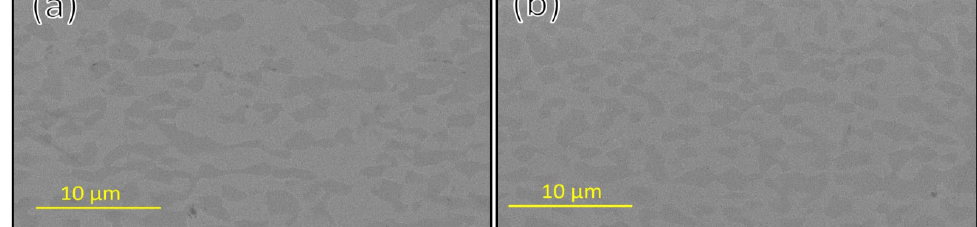
Figure 17. SEM and XEDS analysis of the cross-section of tested titanium alloy sample 9 ( a ) middle of sample 9 and ( b ) one cm from outlet end in the last reactor.